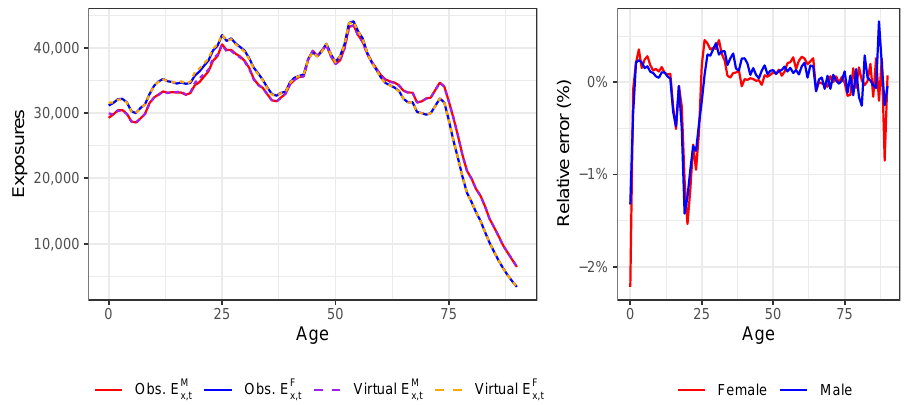
Figure A5. Validating the protocol to construct virtual exposures in the year 2020 for Denmark from the weekly exposures collected in age buckets from the STMF data